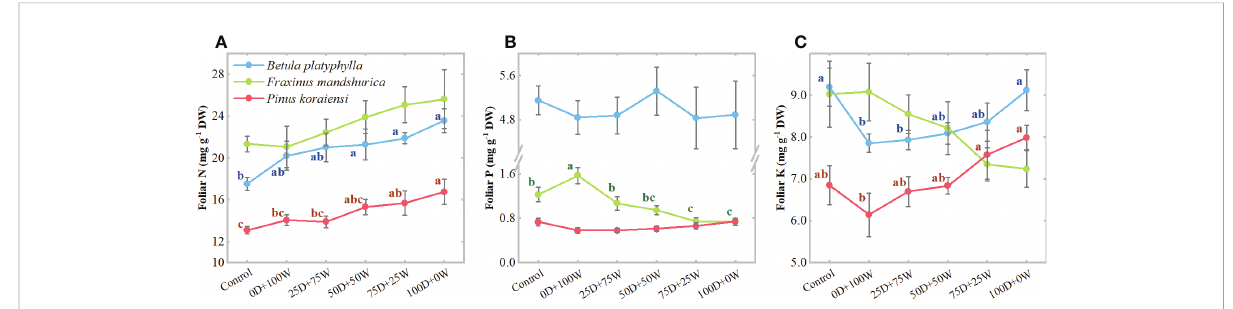
FIGURE 2 Concentrations (mg g -1 DW, A – C ) of foliar: nitrogen (N), phosphorus (P) and potassium (K) of three species affected by six canopy N application treatments for 32 days. N application treatments included a control (no application of N) and fi ve types of N deposition with dry to wet ratios of 0:100 (0D+100W), 25:75 (25D+75W), 50:50 (50D+50W), 75:25 (75D+25W) and 100:0 (100D+0W), respectively. Error bars indicate the standard error of the mean ( n = 5). Within the same species in each panel, different letters on the left side of the error bar demonstrate signi fi cant differences among six treatments ( P < 0.05) according to the least signi fi cant difference test. The scales of the y -axis are different in each